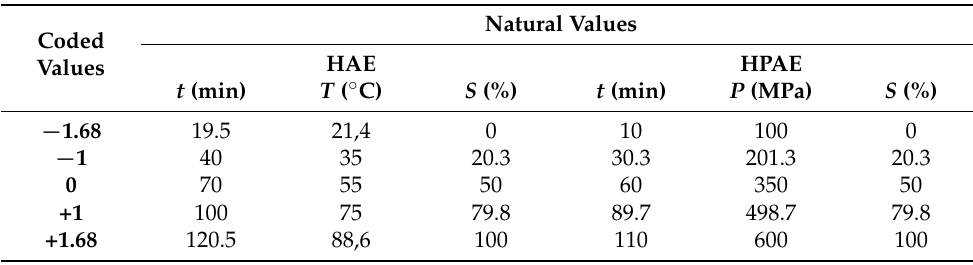
Table 1. Experimental domains and coding of the independent variables in the CCCD factorial design with five levels of